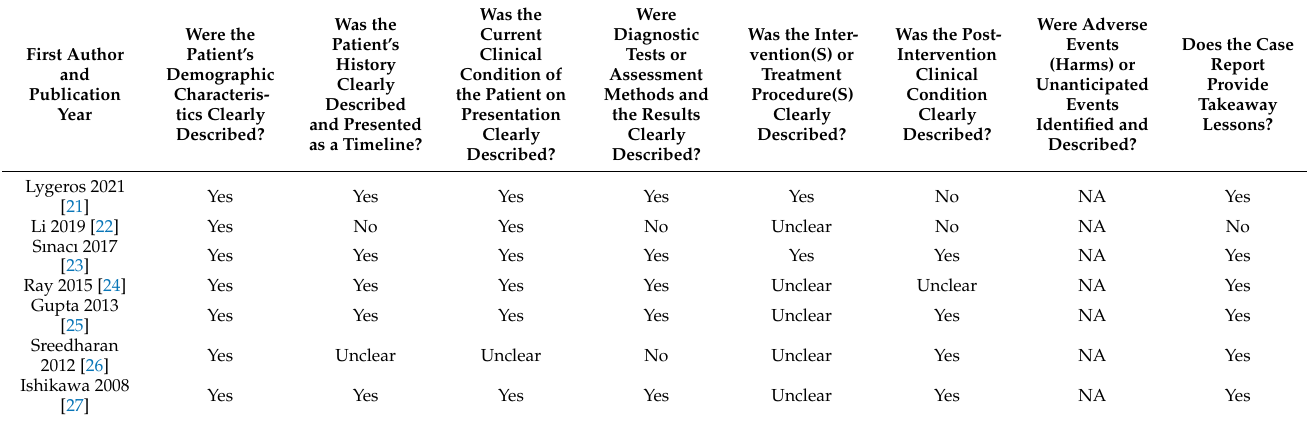
Table 7. Risk of bias assessment. NA—Not